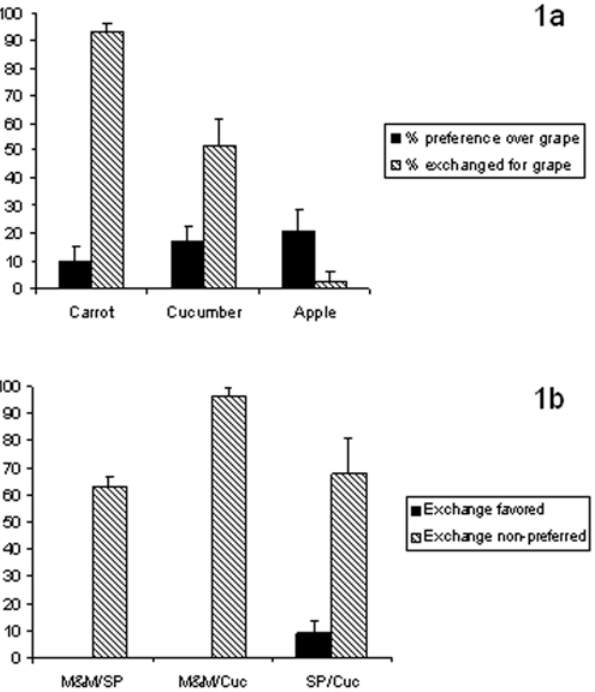
Figure 1. a. Chimpanzees were much less likely to exchange food commodities than their preferences would indicate when the endowed and available foods were close in value. Figure 1a indicates the percentage of times ( 6 SE) chimpanzees at Bastrop chose to exchange a food for a grape (hatched bars) as compared to their preference for that food in comparison to grape (solid bars). Note that although grape was vastly preferred to all other foods, there was great variation in the willingness to give other foods up in return for a grape, with subjects exchanging virtually all carrots and virtually no apples. b. Indicates the percentage of times ( 6 SE) chimpanzees at the Language Research Center chose to exchange one food for another. The x-axis indicates each food pairing; black bars indicate the percentage of times favored foods were exchanged for non-preferred foods and the hatched bars indicate the percentage of times non-preferred foods were exchanged for preferred foods. Favored and non-preferred were independently determined for each pair with respect to each other (favored foods are listed first for each category). As expected, subjects virtually never traded a favored food for a non-preferred food. However, subjects frequently chose to consume non-preferred foods rather than trade them for favored foods. Chimpanzees at Bastrop preferred higher value food items at least 80% over lower valued ones, and preferences were absolute for LRC chimpanzees (100% for M&Ms over both other foods, and 100% for sweet potato over cucumber). M&M=M & M brand chocolate candies, SP=uncooked sweet potato cubes, Cuc=raw cucumber pieces.